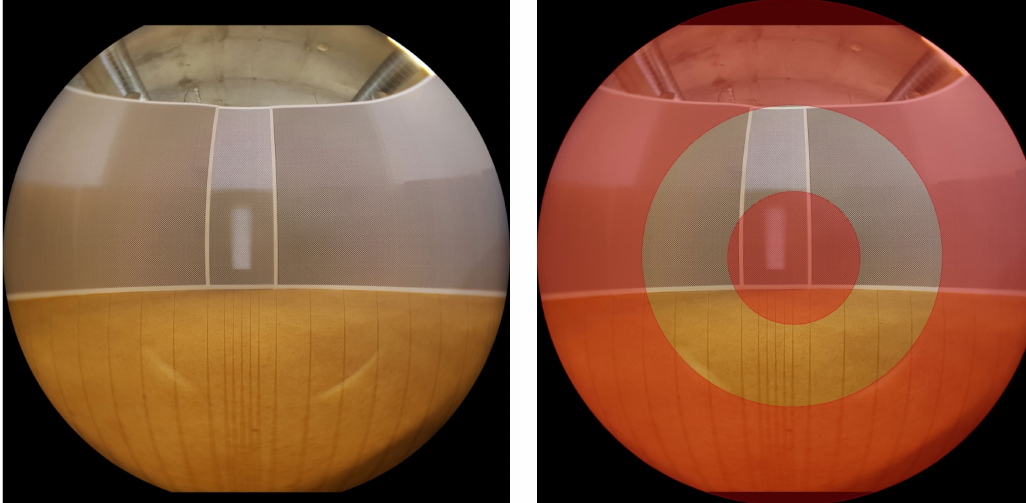
Figure 21. On the right is the original image captured by Samsung S7 with fisheye lens, and on the left the blurred areas were